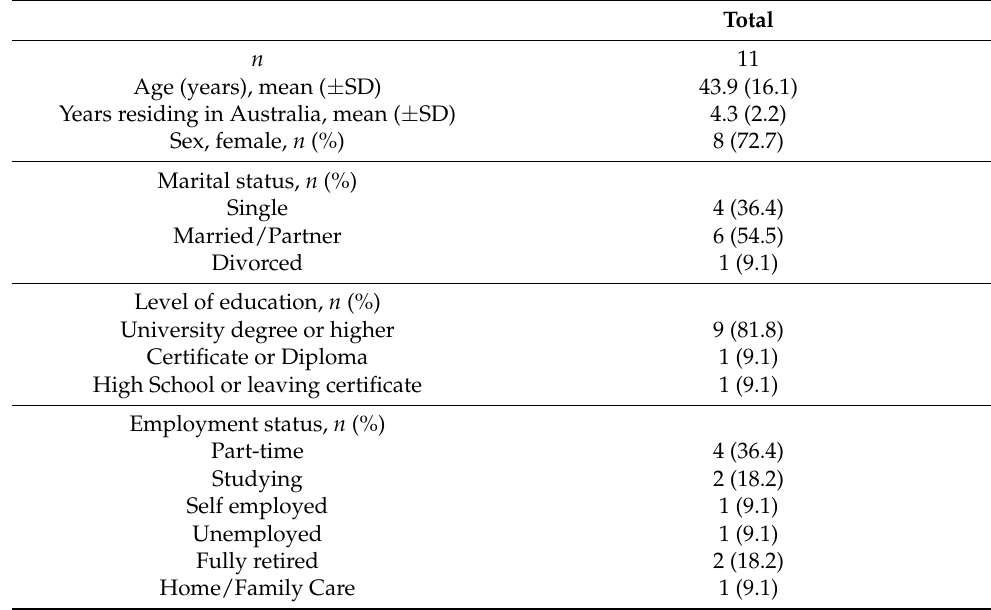
Table 2. Demographic characteristics of Chinese immigrants completing interviews ( n =